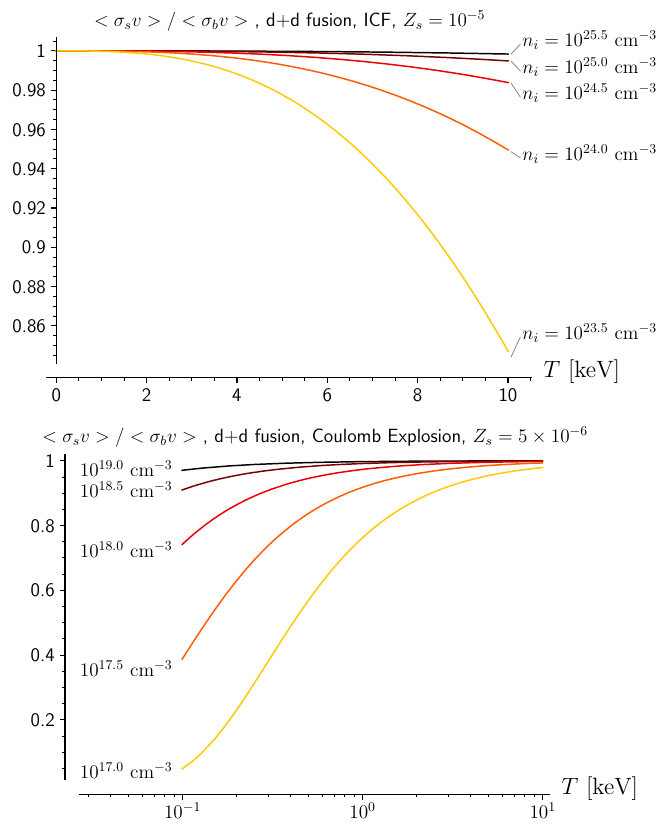
Figure 1. Rate enhancement factors from eq. (2), calculated using eq. (5), as a function of the reactants temperature T , for d + d fusion. Each color represents a di ff erent number density of nuclei n i as marked by the labels. Top panel describes an ICF plasma made of only hydrogen isotopes, and bottom panel a cluster Coulomb explosion system. Top and bottom panel refer to a net charge per nucleus respectively of 10 − 5 and 5 × 10 − 6 proton